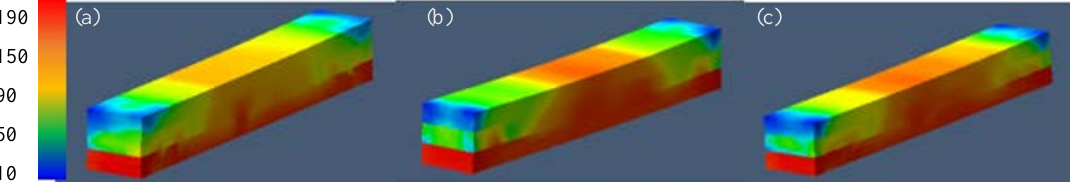
Fig. 7. The residual stress nephogram of the sample (MPa): (a) 100mm/s; (b)200mm/s;